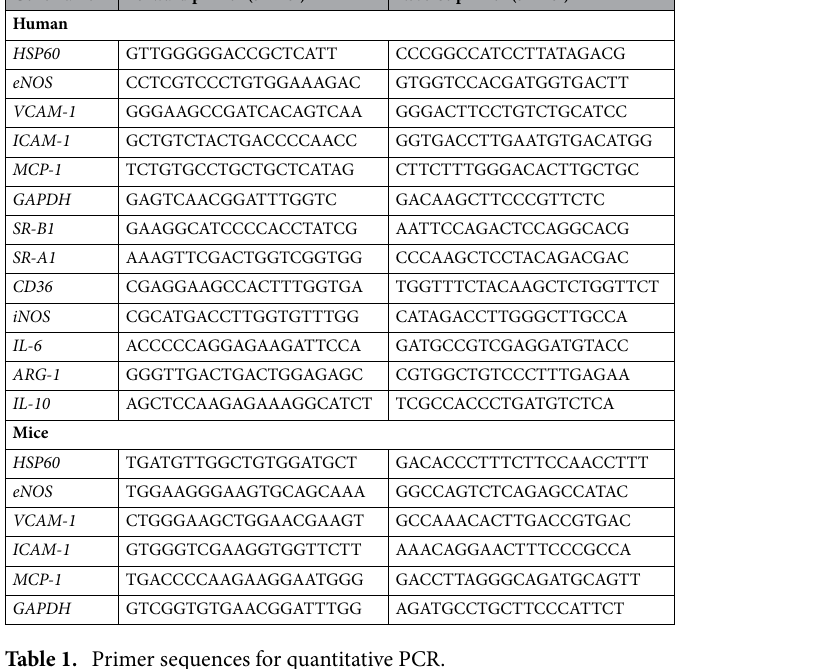
Table 1. Primer sequences for quantitative